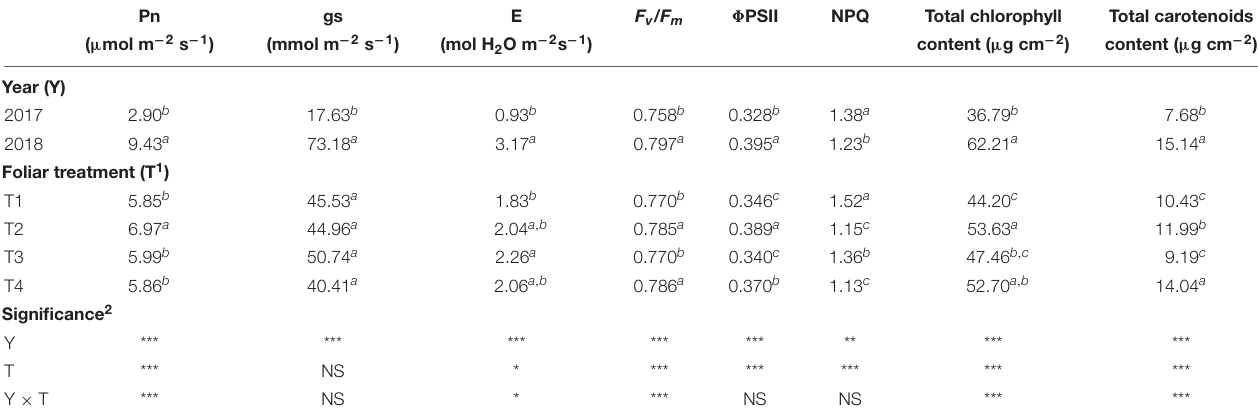
TABLE 3 | Main effects of year and foliar treatment, on net photosynthetic rate (Pn), stomatal conductance (gs), leaf transpiration rate (E), maximum quantum efficiency of PSII photochemistry ( F v / F m ), quantum yield of PSII linear electron transport ( (cid:56) PSII ), non-photochemical quenching (NPQ) and leaf pigment quantification of V. vinifera “Aglianico” vines at veraison. Mean values and significance of main factors’ interactions are shown. Different letters within column indicate significant differences according to Duncan’s multiple-range test ( P ≤ 0.05). Pn gs E F v / F m